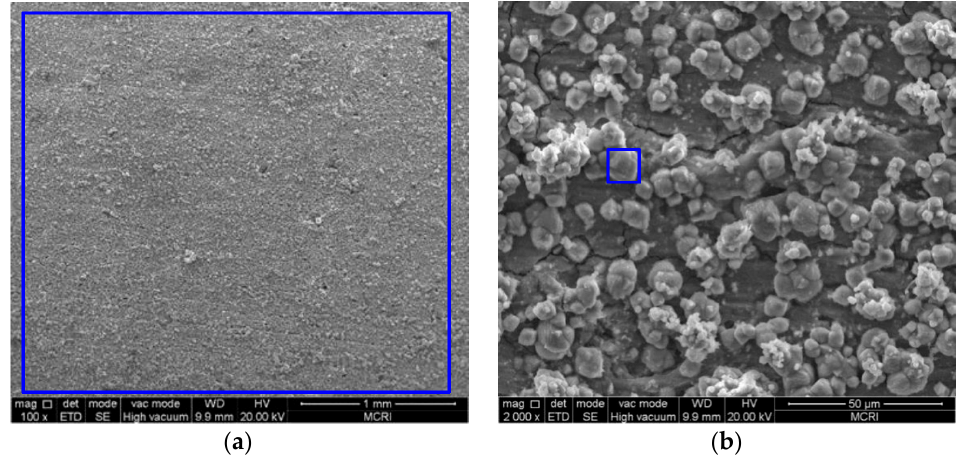
Figure 6. SEM images of the corrosion scales formed on the steel surface in 30% crude oil/brine mixtures at Pco 2 = 1.5 MPa: ( a ) ×100; ( b ) ×2000.